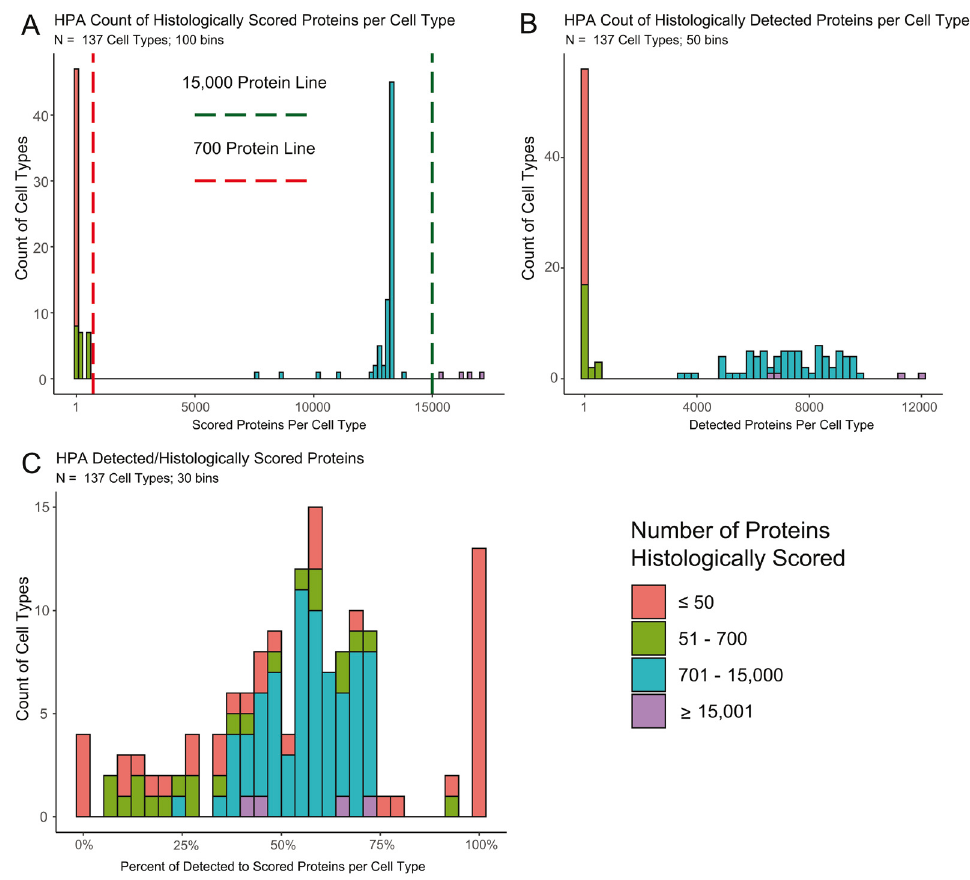
Figure 1. Histograms comparing how often proteins stain to how often they are evaluated in HPA. A . A histogram of the 137 cell types showing the amount of proteins histologically scored in each cell type. Four cell types were evaluated for >15,000 proteins (green line) and 61 for <700 proteins (red line). This bimodal distribution shows that there are nearly separate groups of cell types based on how often they are scored. B . A histogram of the 137 cell types on the amount of proteins that had positive staining in each cell type. This distribution reveals an expected skew, cell types that are more often histologically scored, tend to have a higher count of proteins detected. C . A histogram of the percent of positively stained proteins to the total amount of histologically scored proteins for the given cell type. The extreme ends of the distribution are populated by samples with less than 700 scored proteins revealing that seldom scored cell types staining frequencies are often